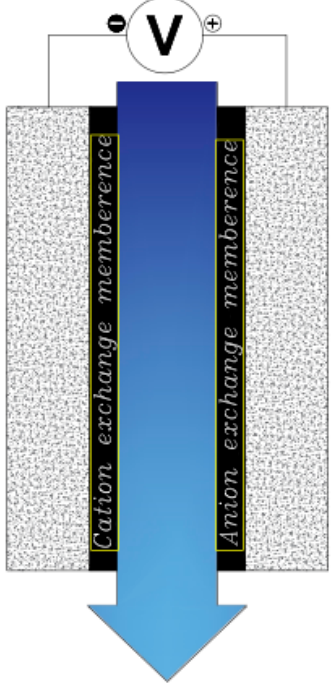
Figure 5. Ion exchange membrane in CDI cell.